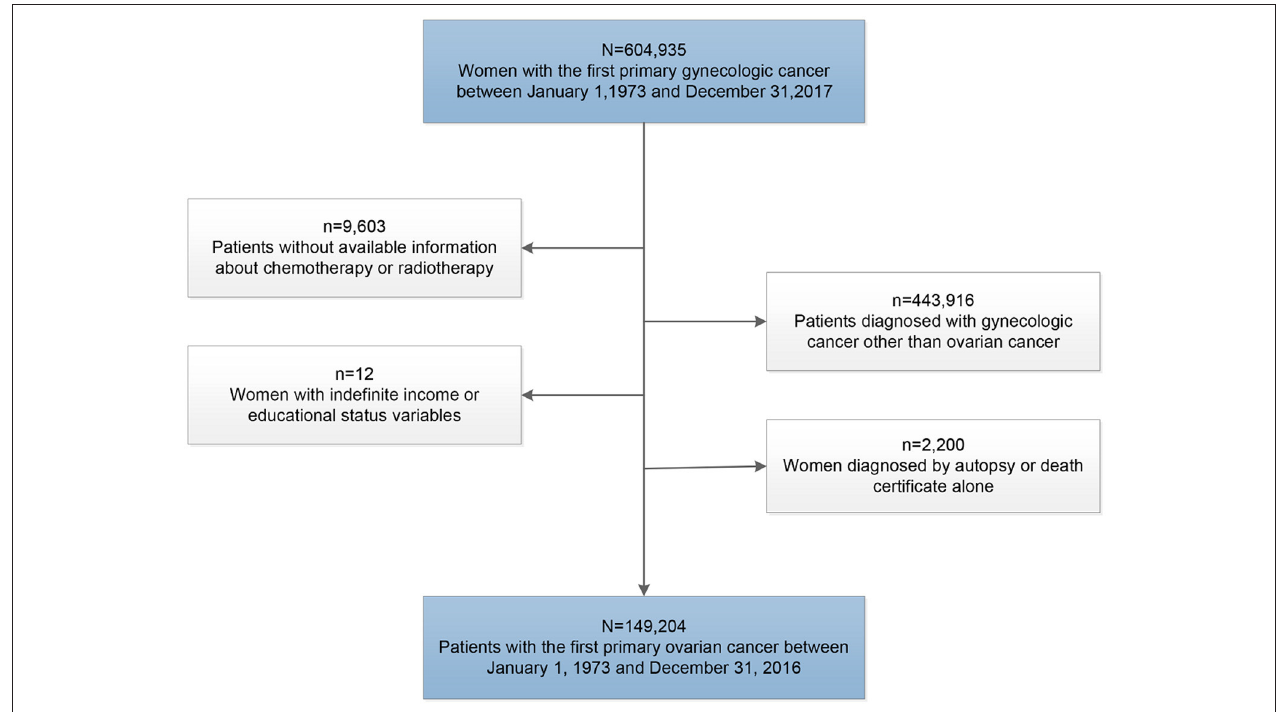
FIGURE 1 | Flow diagram of patient selection within the SEER 18 registries between 1973 and